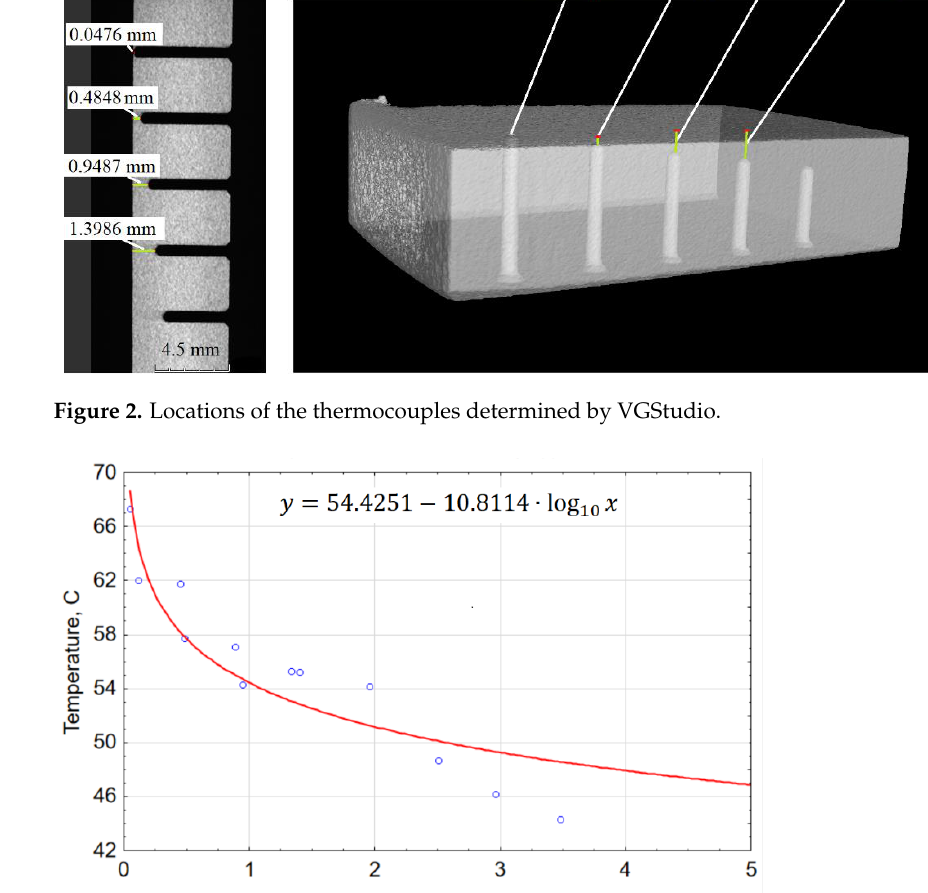
Figure 3. Temperature against distance from the edge in AWJM.